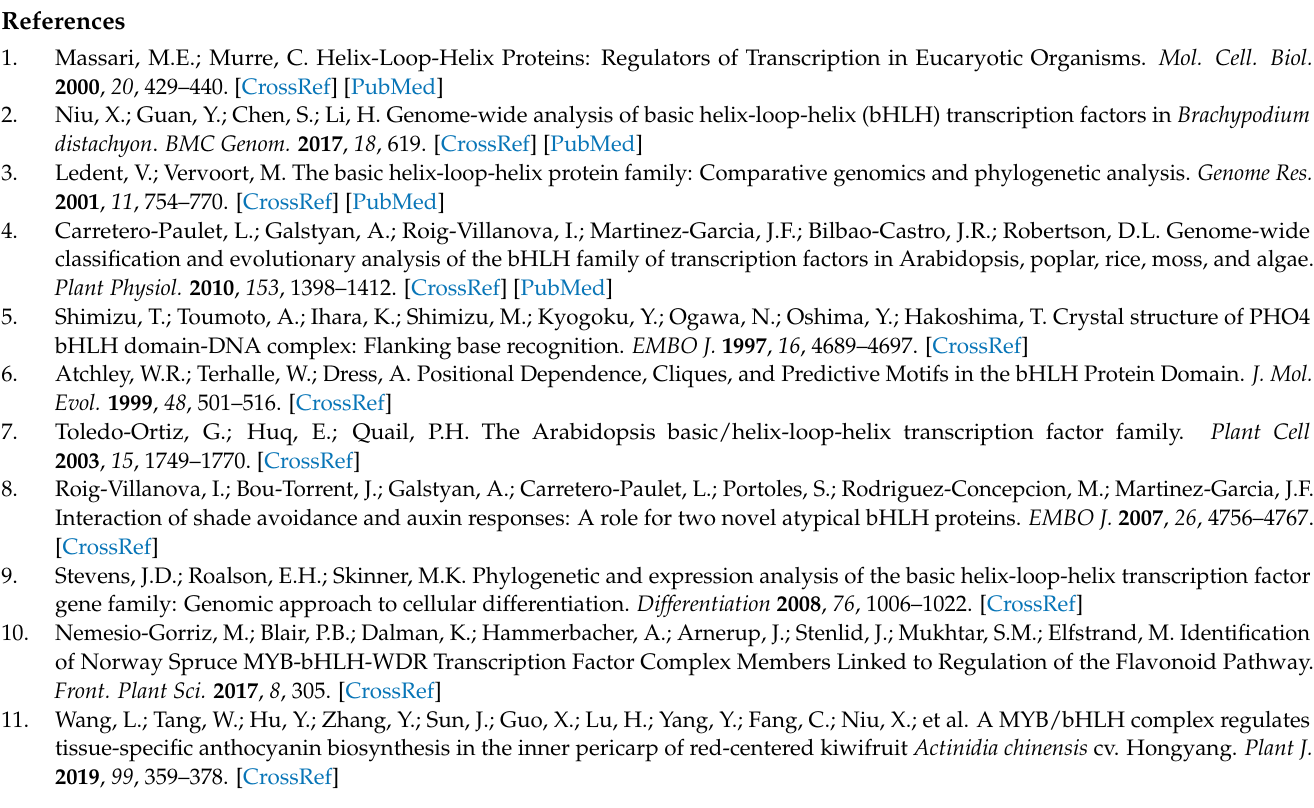
Figure S2: Sequence logos of 10 conserved motifs detected in the QmbHLHs; Figure S3: The cor- relations between QmbHLH gene expression patterns; Table S1: FPKM values of QmbHLH genes in different tissues; Table S2: Primers used in the qRT-PCR; Table S3: Characteristic information of identified QmbHLH genes in Mongolian oak; Table S4: The tandem duplication events of QmbHLH genes; Table S5: The 18 pairs of segmental duplicates in QmbHLH genes; Table S6: One-to-one orthologous relationships between Quercus mongolica and Arabidopsis thaliana ; Table S7: One-to-one orthologous relationships between Quercus mongolica and Populus trichocarpa